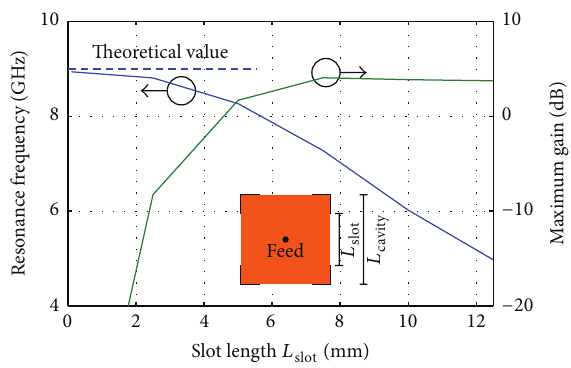
Figure 4: Influence of slot length on the resonance frequency and maximum gain of the simplified structure shown in the inset for = 16 mm. 𝐿 cavity